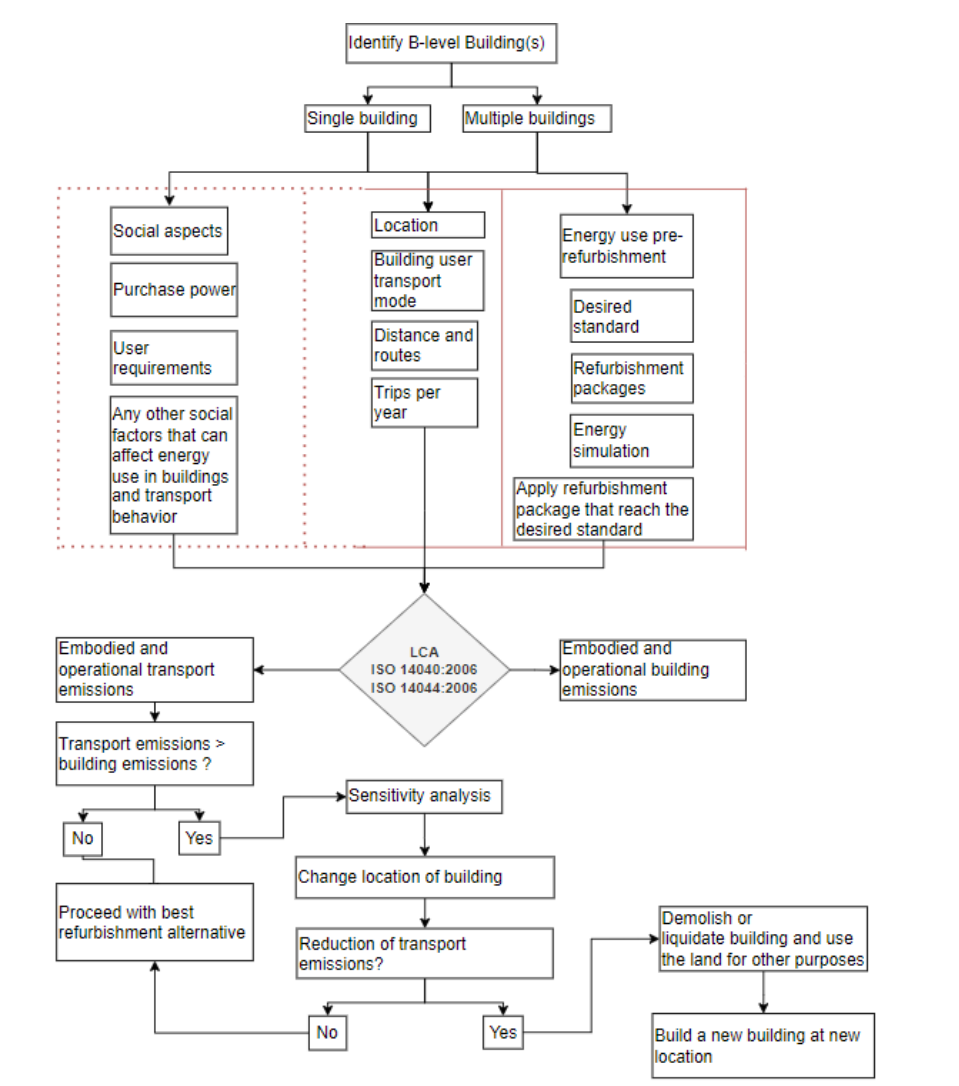
Figure 6. Theoretical framework based for holistic assessment of refurbishment strategies for existing